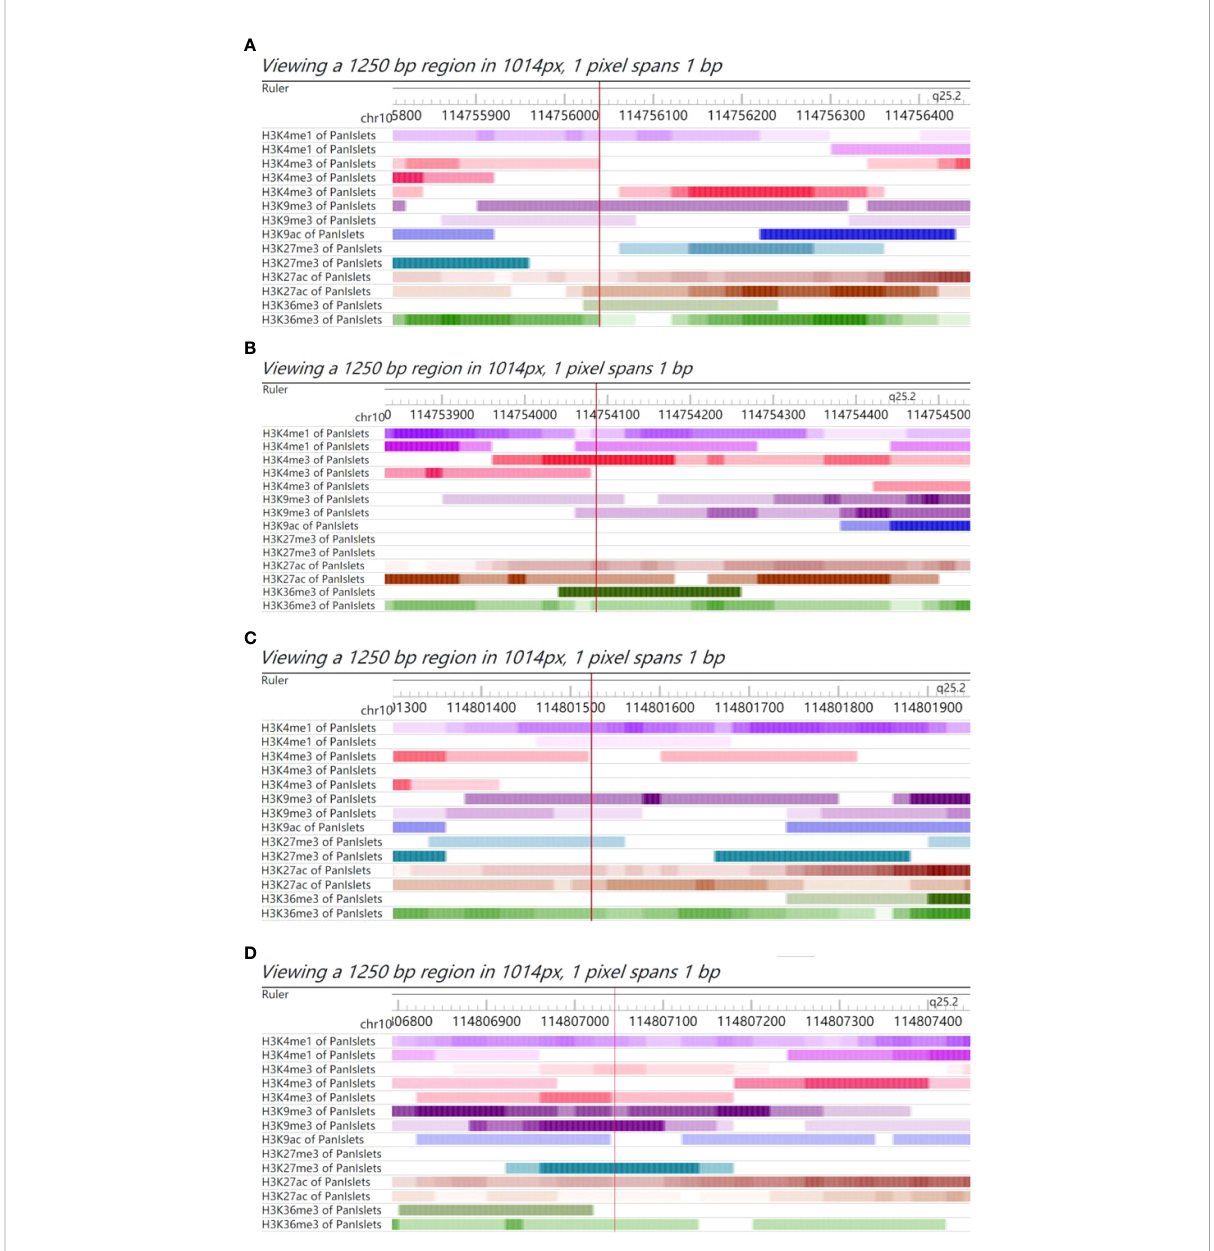
FIGURE 2 Chromatin features of rs4506565, rs7901695, rs7895340, and rs11196205. Functional annotation in proximity to rs4506565 (A) , rs7901695 (B) , rs7895340 (C) , and rs11196205 (D) location in pancreatic islets from Roadmap data. ChIP-seq tracks (H3K4me1, H3K27ac, H3K4me3, H3K9me3, and H3K27me3) for histone marks are present. The red vertical lines guide the position of rs4506565, rs7901695, rs7895340, and rs11196205. The colored stripes represent the density